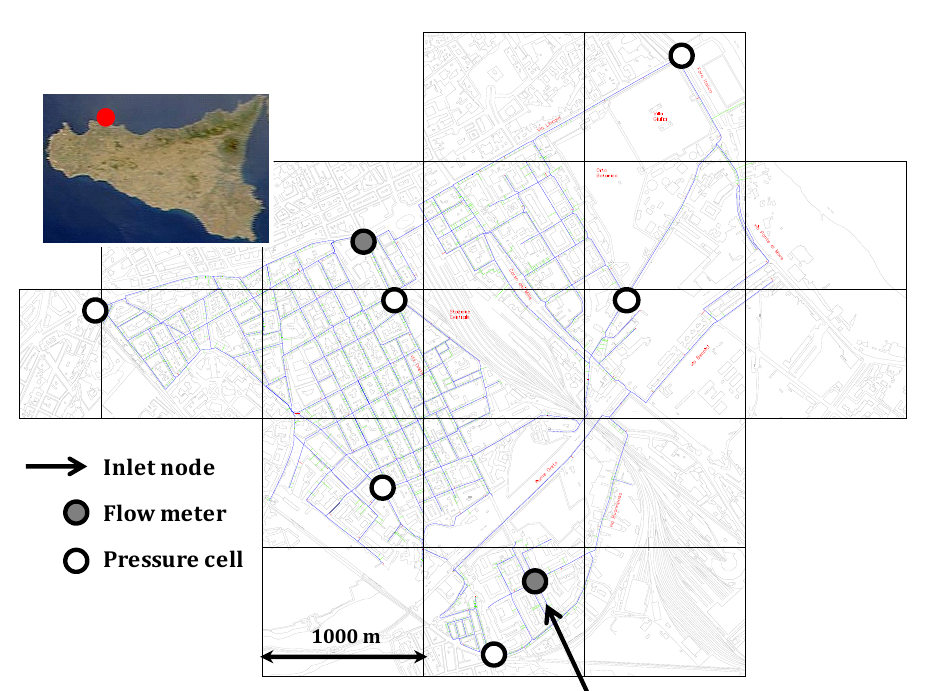
Figure 4. A schematic of the